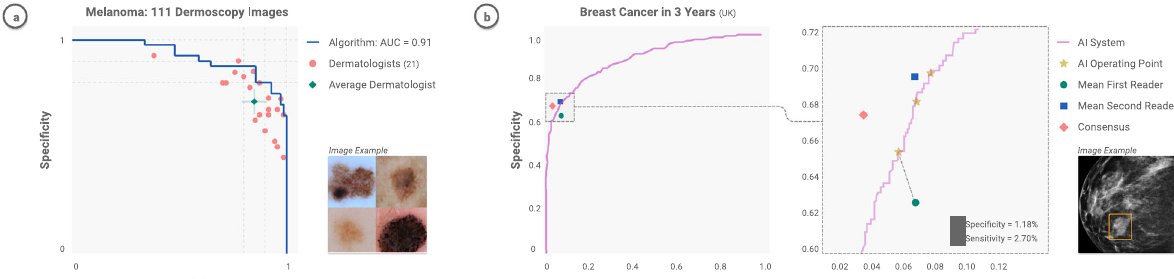
Fig. 2 Physician-level diagnostic performance. CNNs — trained to classify disease states — have been extensively tested across diseases, and benchmarked against physicians. Their performance is typically on par with experts when both are tested on the same image classi fi cation task. a Dermatology 7 and b Radiology 156 . Examples reprinted with permission and adapted for